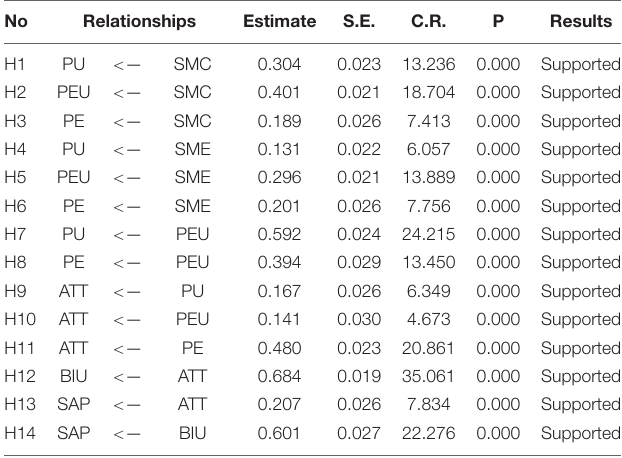
TABLE 4 | Regression weights: (Group number 1–Default